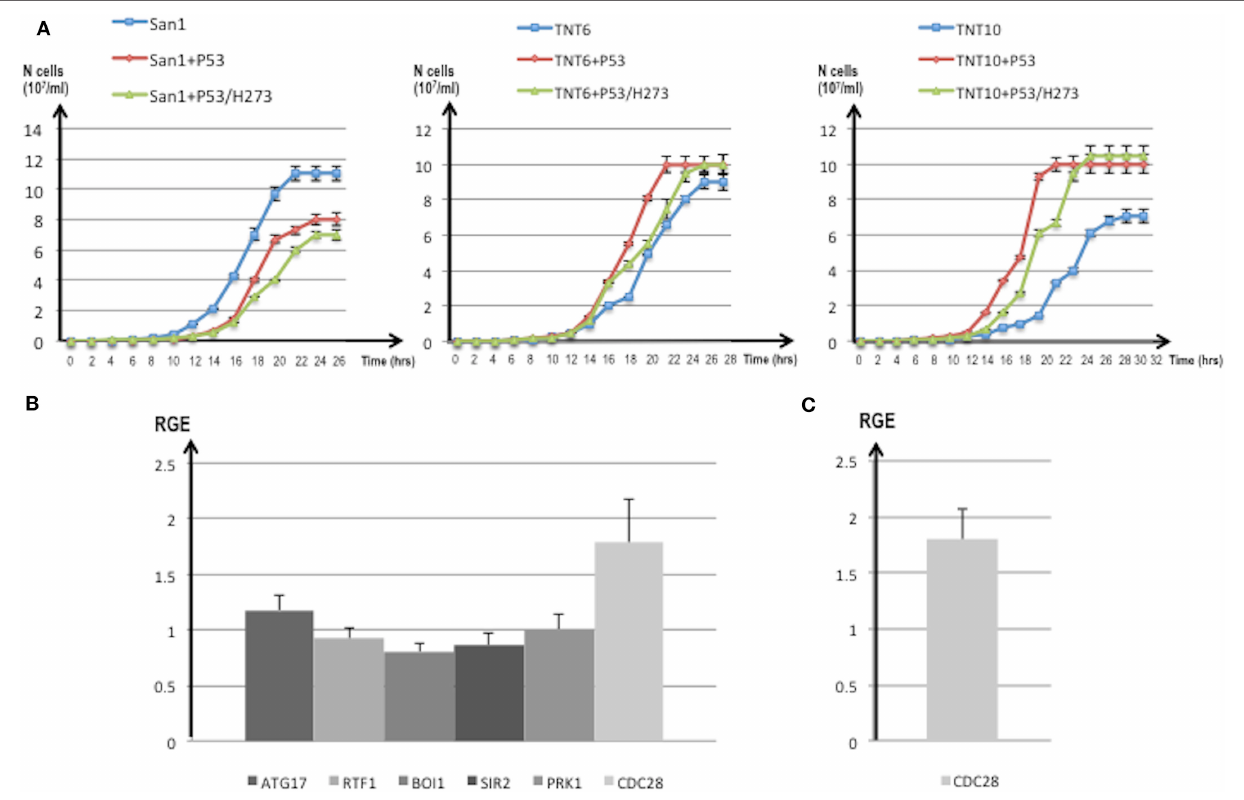
FigUre 8 | (a) Growth curves of translocants number 6 (TNT6) and 10 (TNT10) and of the wild type (WT) San1. The curves without P53 (blue), with P53 (red), and with the P53 mutant H273 (green) are shown for San1 (left), TNT6 (center), and TNT 10 (right panel). On the X -axis, the growth time (in hours), and on the Y -axis the cell number (10 7 /ml) are reported. Each aliquot was retrieved every 2 h and cell density determined by counting each aliquot three times on a Neubauer Improved Cell counting chamber. Error bars are reported accordingly. (B) Relative gene expression (RGE) of six genes ( ATG17 , RTF1 , BOI1, SIR2 , PRK1 , CDC28 ) measured in TNT6 with P53. As reference, TNT6 transformed with an empty PJL49 plasmid was used (see Materials and Methods for details on the comparative method). CDC28 increases 1.79-folds. (c) RGE of CDC28 in San1 transformed with P53. The increase of CDC28 is 1.8-folds respect to San1 transformed with an empty plasmid. The bars represent the average of three independent readings (bar errors are reported and calculated as standard error). (D) The expression of the mutant P53/H273 was normalized respect to the WT form of P53 taken as 1 in the WT strain San1 and in two different translocants (TNT6 and TNT10). RGE was calculated using ACT1 as reference gene and following the procedure described in Section “Materials and Methods.” Error bars are reported